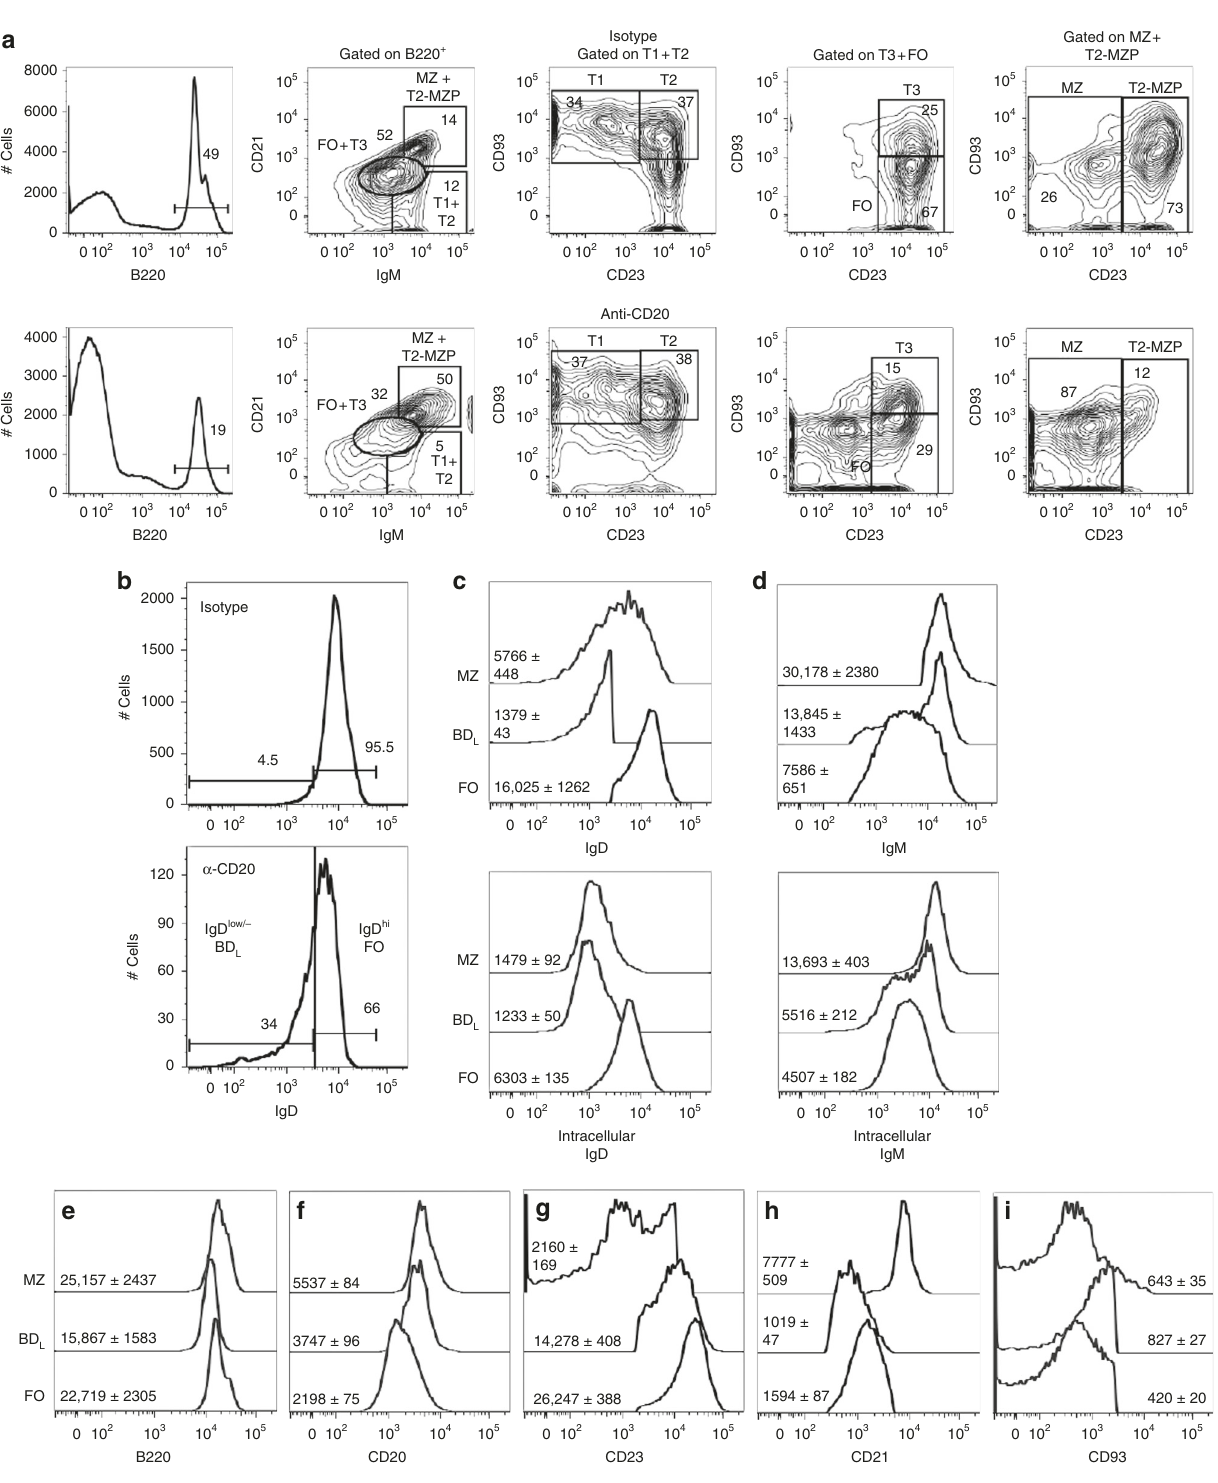
Fig. 2 Retained B cells after anti-CD20 IgG 1 depletion are enriched for IgD low/ − expression. a Representative fl ow cytometry gating strategies in B10.PL mice are shown for splenic B220 + B cells differentiating T1, T2, T3, T2-MZP, FO, and MZ B cells utilizing differential expression of IgM, CD21, CD23, and CD93 14 days after administration of isotype (top row) or anti-CD20 IgG 1 (bottom row). b IgD expression was assessed on the FO B cell subset from a . c – i WT C57BL/6 mice were used to assess expression levels of IgD ( c ), IgM ( d ), B220 ( e ), CD20 ( f ), CD23 ( g ), CD21 ( h ), and CD93 ( i ) on MZ, BD L , and FO B cells by fl ow cytometry. The mean fl uorescence intensity ± SEM is shown from nine mice